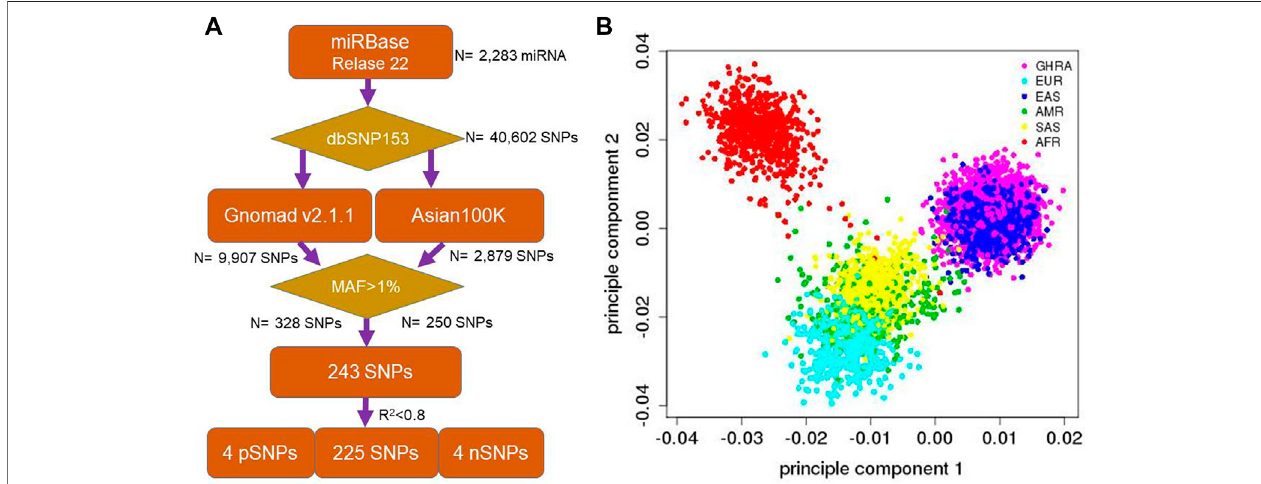
FIGURE 1 | Flowchart for SNP and sample selection as well as population ancestry of GHRA cohort. (A) human microRNAs were downloaded from miRBase (Release 22.1). We mapped all the dbSNP153 SNPs into human microRNA genomic regions and 40,602 SNPs were received. We fi lter out non-East common variants withGnomadandAsian100KdatawithMAF > 1%.4positivecontrol( HLA-DRB1 , HLA - DRB9 , HLA - DQB1, and TNFAIP3 )and4ancestrymarkers(SouthandNorthHan Chinese)wereaddedforthequalitycontrol (B) PCAanalysistoshowthepopulationancestryofGuanghuaRheumatoidArthritiscohort(GHRA)with1,000Genome dataset (included in dbSNP153). Symbols are as same as Super Population Code (SPC) from the 1,000 genome project. AFR, African; AMR, Ad Mixed American; EAS, East Asian; EUR, European; SAS, South